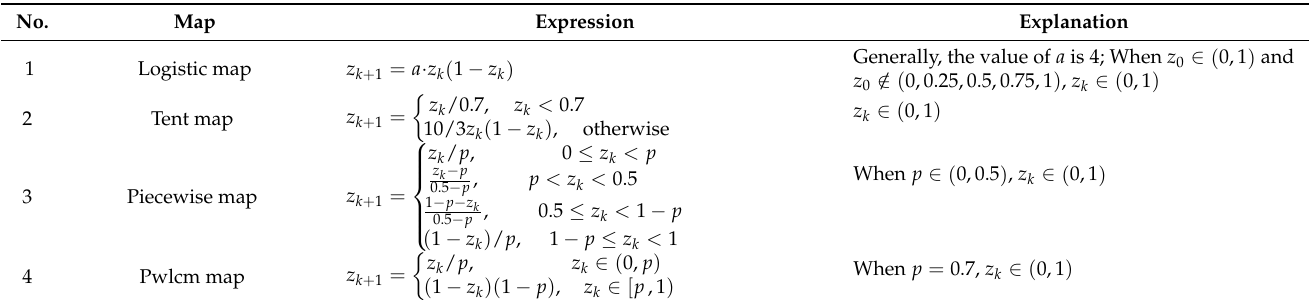
Table 2. Four typical chaotic